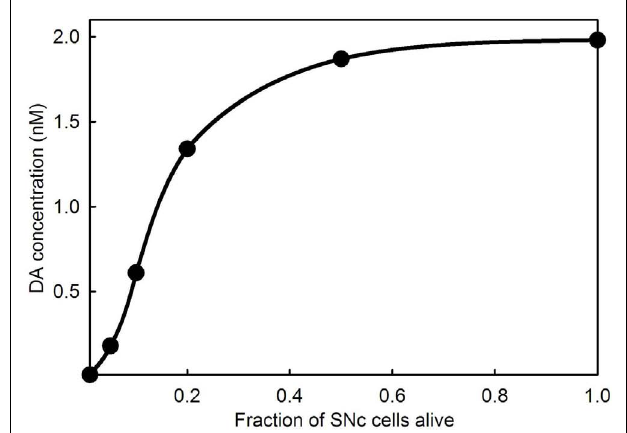
FIGURE 5 | LD changes the firing rate of DRN cells. The 5HT concentration in the striatum (blue curve) and the firing rate of DRN neurons (black curve) are shown during an LD dose.The scale for the blue curve is on the left and the scale for the black curve is on the right.